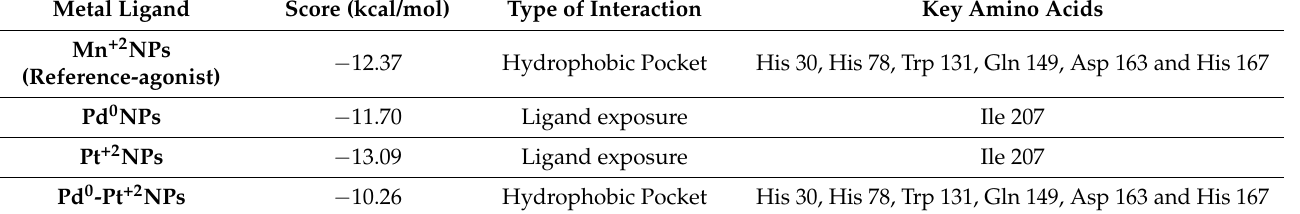
Table 3. Molecular docking of the four dynamic metal models against superoxide dismutase enzyme.